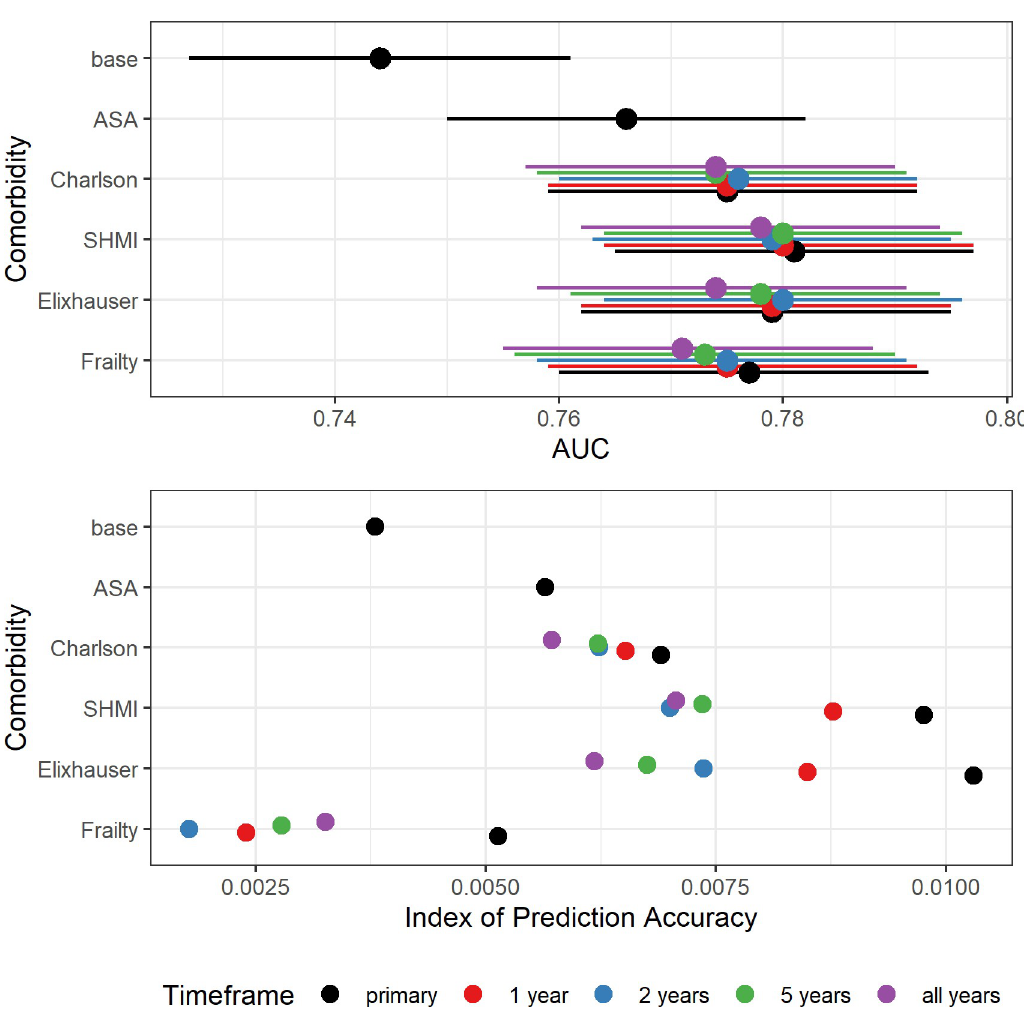
Fig 4. Area under the ROC curves (higher better, lines represent 95% CIs) and IPA scores (higher better) for models of 90-day mortality after KR with ASA grade and the 4 comorbidity indices for all time frames, including age and